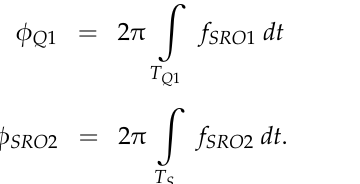
Figure 2. 1-1 Multi-stage noise-shaping (MASH) ∆∑ time-to-digital converter (TDC) architecture using GSRO [20].